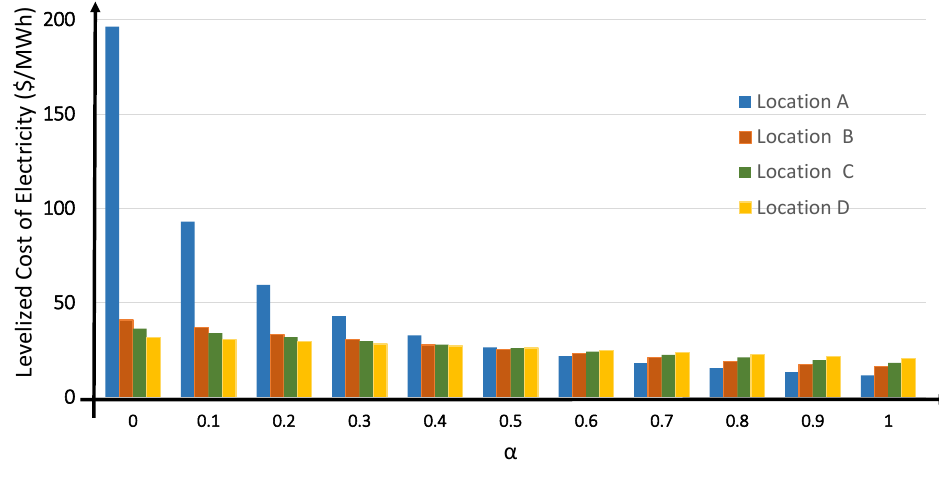
Figure 8. Levelized cost of electricity, ¯ C lev , α , for different values of α